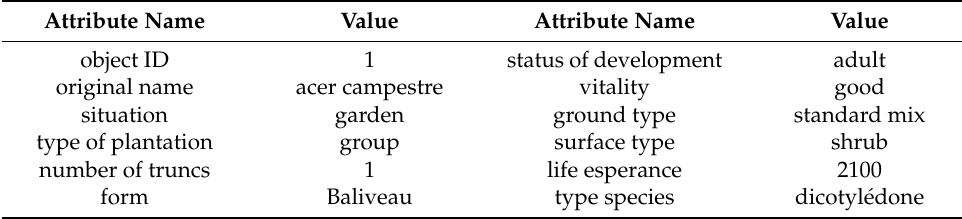
Table 1. Attributes for trees provided by SITG [23] .